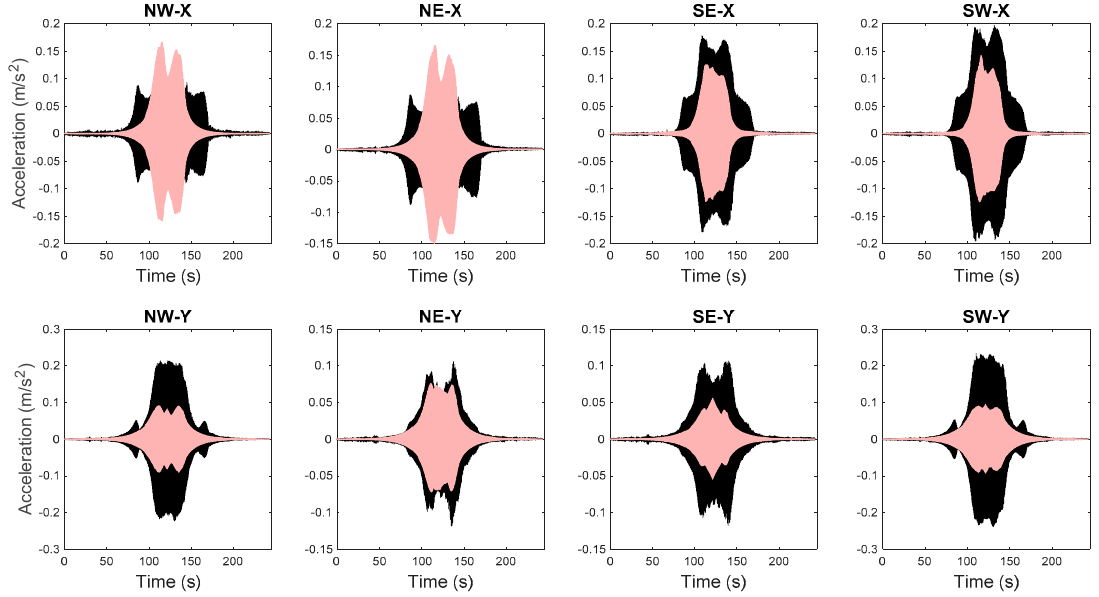
Figure 17. Acceleration time history predictions using ambient vibration level and measured counterparts (light pink areas refer to 95% quantiles and black lines denote measured data) [56].